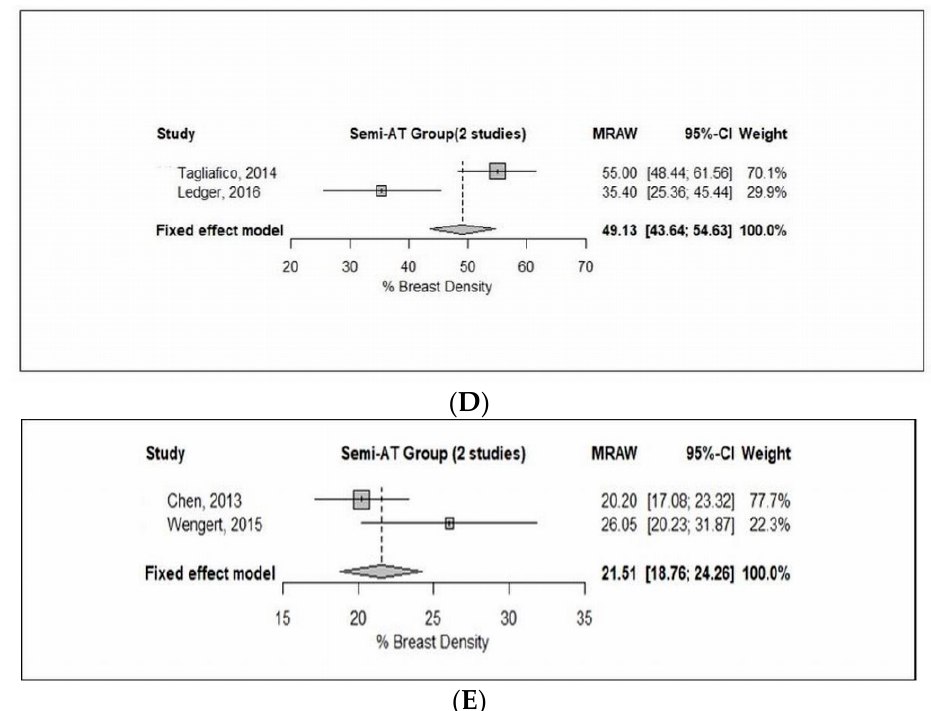
Figure 3. Forest plot of the study means, and 95% confidence limits of the breast density among 21 included studies in the subgroup meta-analyses. ( A ) Fixed e ff ect meta-analysis of the fuzzy c-mean clustering (FCM) group of studies of % breast density. ( B ) Fixed e ff ect meta-analysis of the FCM group of studies of % dense breast volume. ( C ) Fixed e ff ect meta-analysis of the FCM and N3 group of studies of % breast density. ( D ) Fixed e ff ect meta-analysis of the semi-automated threshold group of studies of % breast density. ( E ) Fixed e ff ect meta-analysis of the semi-automated threshold group of studies of % breast